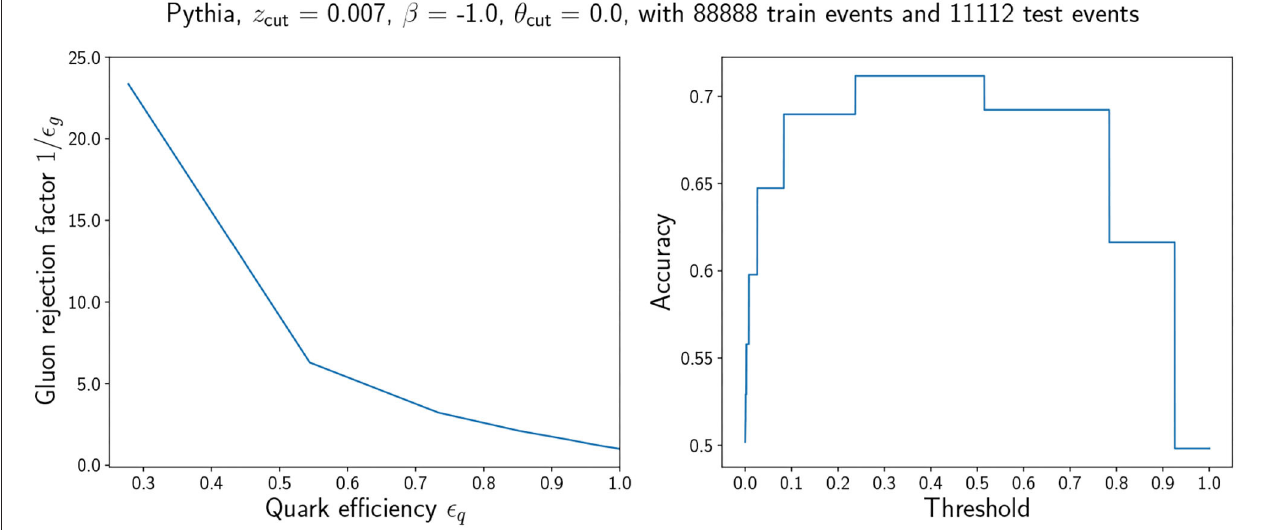
FIGURE 4 | Left: ROC curve for a good hyperparameter choice (AUC = 0.77). Right: Accuracy as a function of threshold for the same hyperparameter choice. We observe that the accuracy is constant in regions and that it is maximum in the region that contains the default decision boundary p ( z behavior of the accuracy can be traced back to the probabilistic classifier dependence on the discrete n SD . A jet can have a discrete set of n SD and thus a discrete set of p ( z quark) values. =